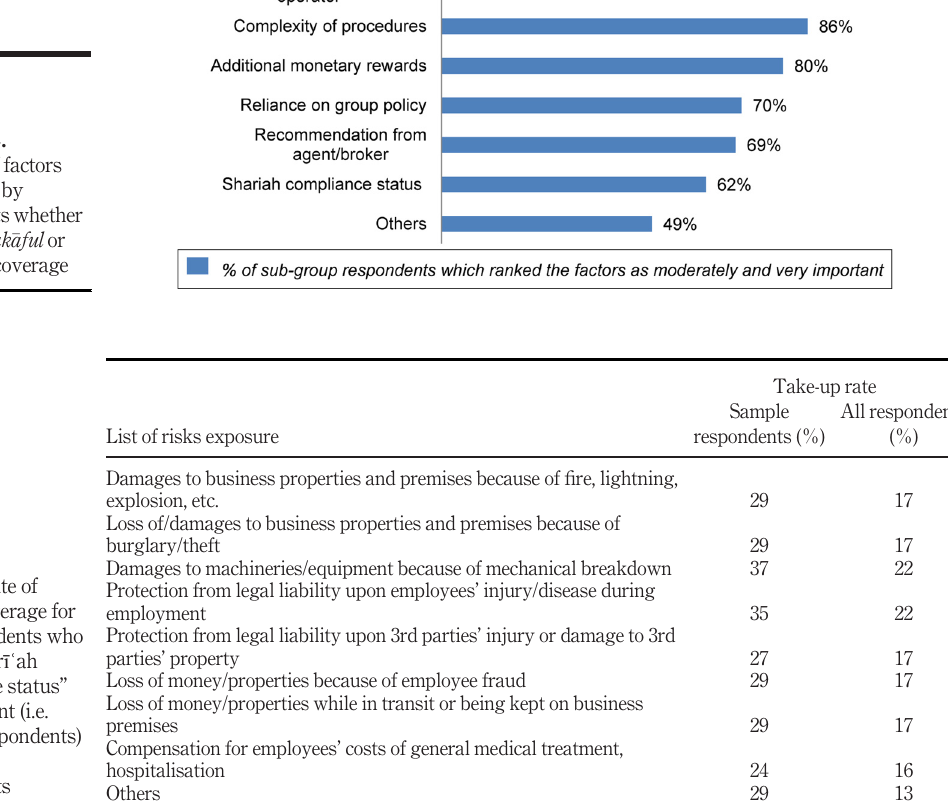
Table III. Take-up rate of tak (cid:1) aful coverage for the respondents who rated “ Shar ī ʿ ah compliance status ” as important (i.e. sample